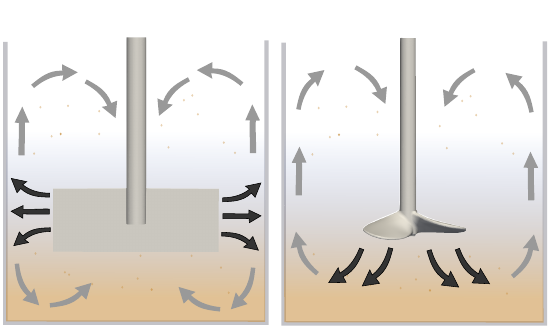
Figure 1. Typical circulation zones in a jar with a radial ( left ) and axial ( right ) impeller (redrafted from Marshall and Bakker